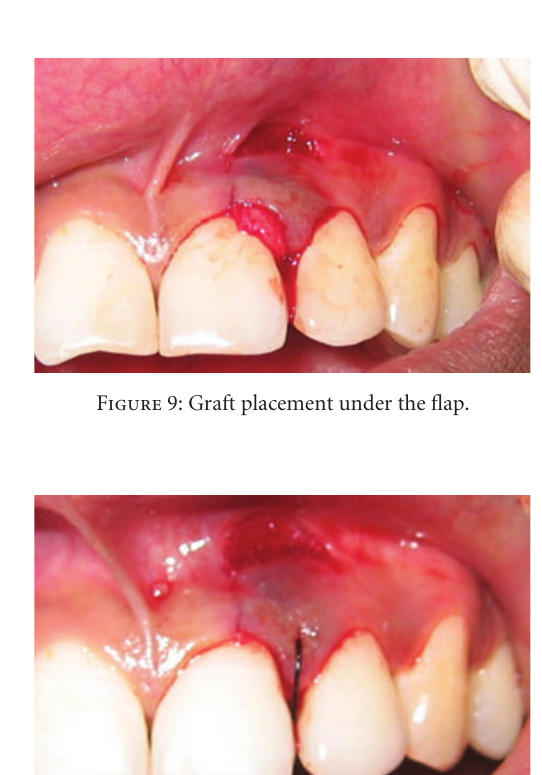
Figure 8: Connective tissue graft taken from palate.